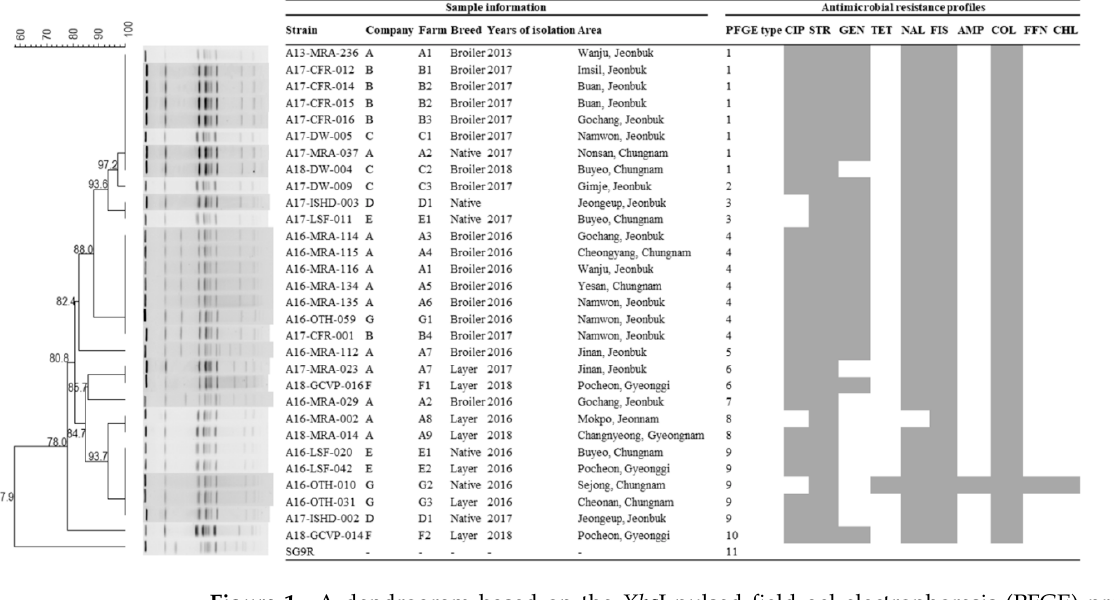
S. enterica ser. Gallinarum isolates from chicken. Corresponding antimicrobial susceptibility patterns to the 18 indicated antimicrobials. Gray squares represent resistance.